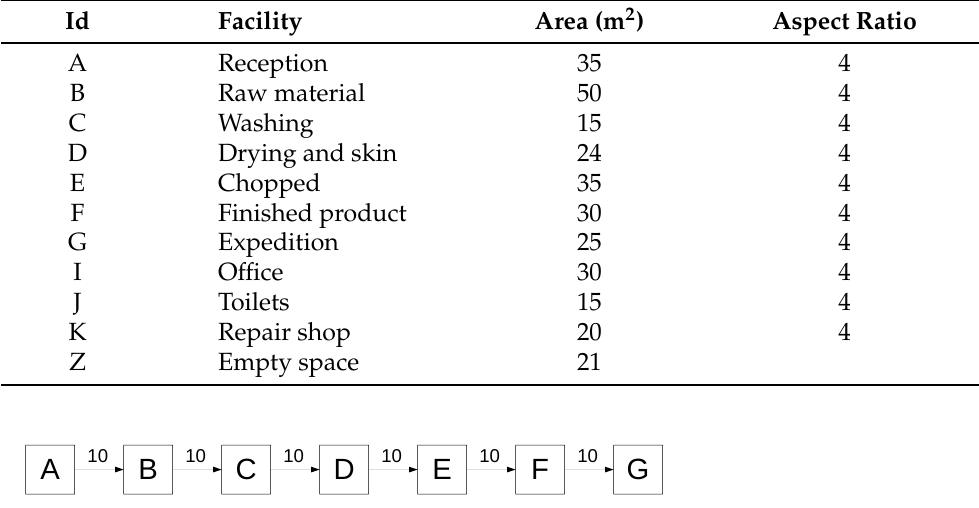
Table 6. Facility features for the ChoppedPlastic problem.